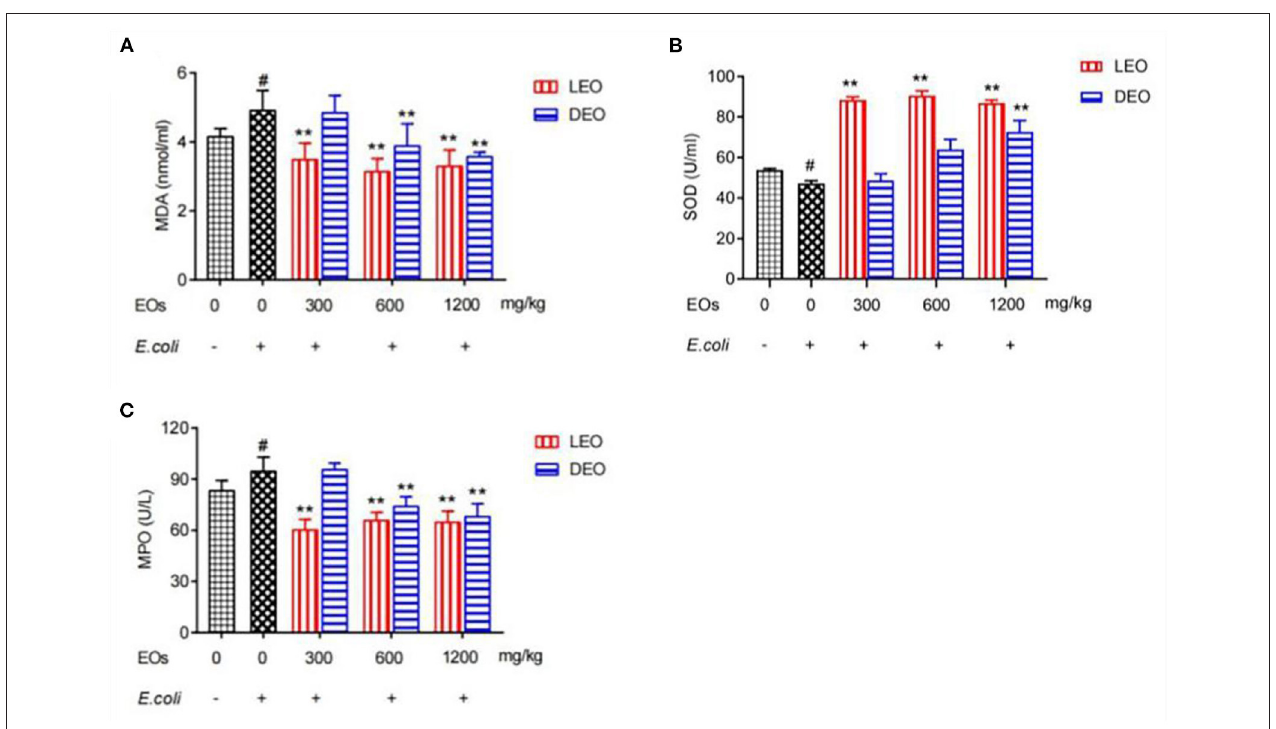
FIGURE 1 | Effects of LEOand DEO on plasma concentration of malondialdehyde [MDA; (A) ], superoxide dismutase [SOD; (B) ], and myeloperoxidase [MPO; (C) ] in E. coli injected mice. Data were presented as mean ± standard error of mean (SEM) ( n = 8). The 1st column was normal saline group (NS) with no E. coli and no EO. The 2nd column was the E. coli group with no EO. The 3rd − 8th column are the LEO and DEO groups with doses at 300, 600, and 1,200 mg/kg BW, respectively. # P < 0.05 E. coli group compared with NS group. Essential oil (E) and its different doses (D) had significant effects on plasma antioxidant indexes ( P for MDA, SOD, and MPO, and their interaction (E × D) was significant ( P E × P D < 0.01). ** P < 0.01, EO groups compared with E. coli group. LEO, lemon essential oil; DEO, d-limonene essential oil.